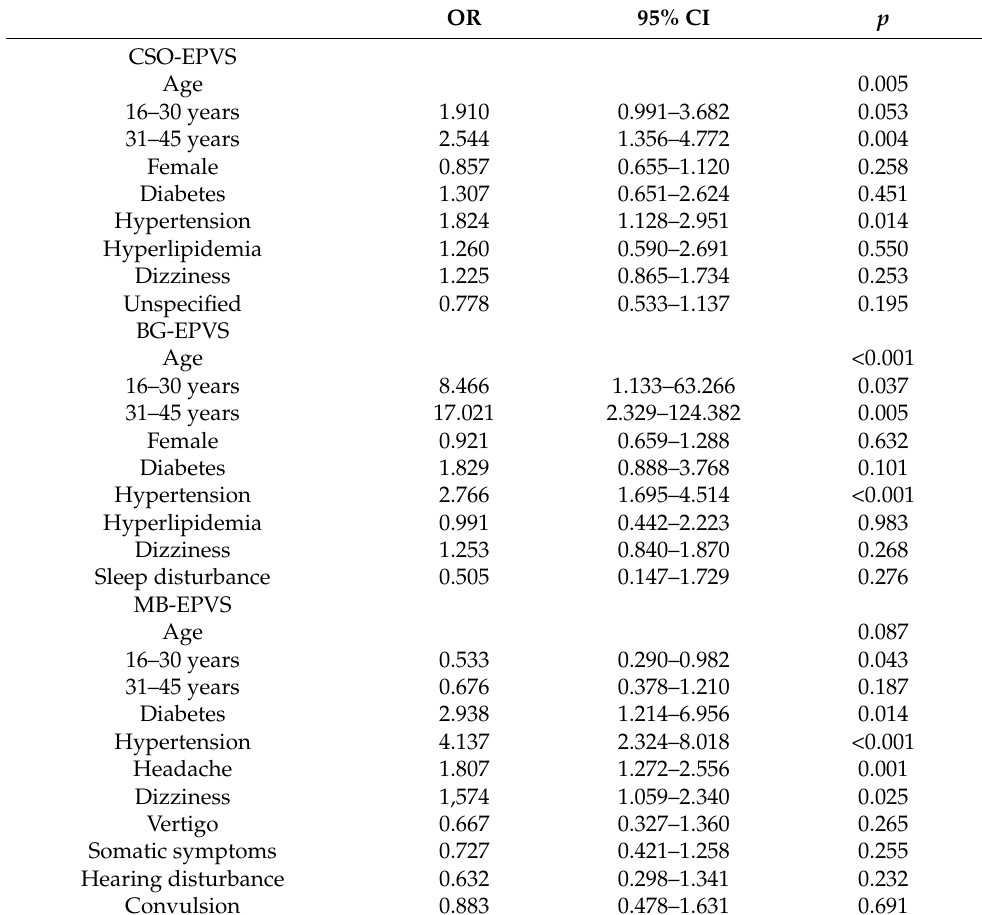
Table 4. Logistic regression analysis for independent predictors of EPVS degree in different regions of the